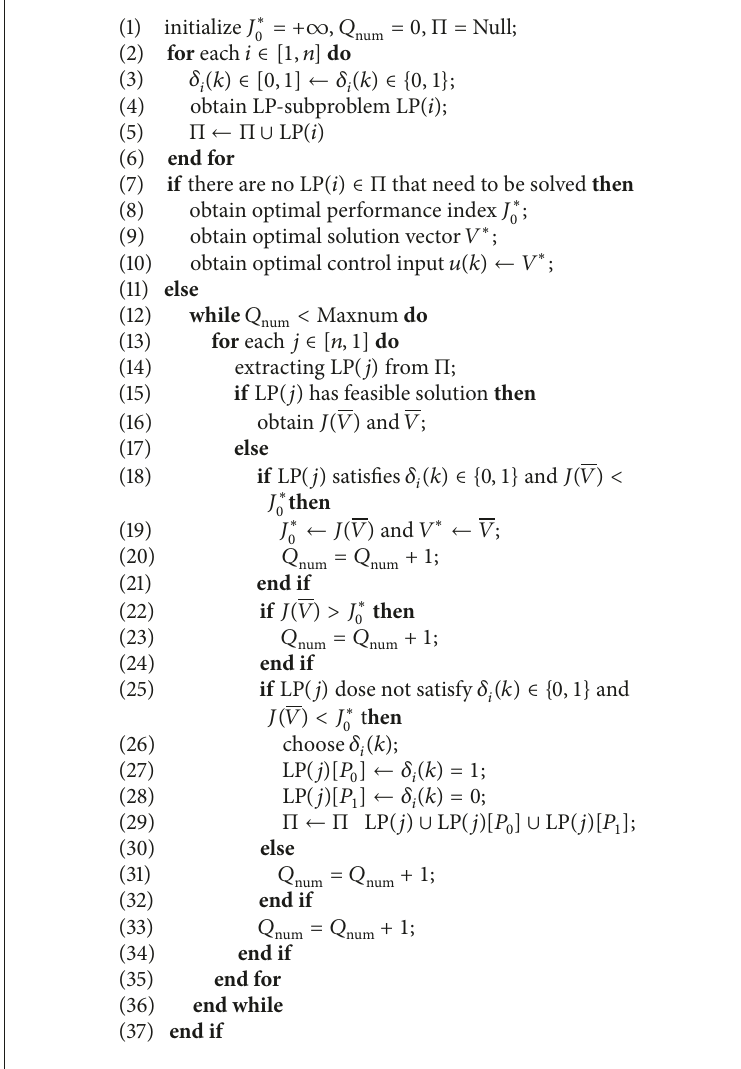
Algorithm 1: Solution of MILP